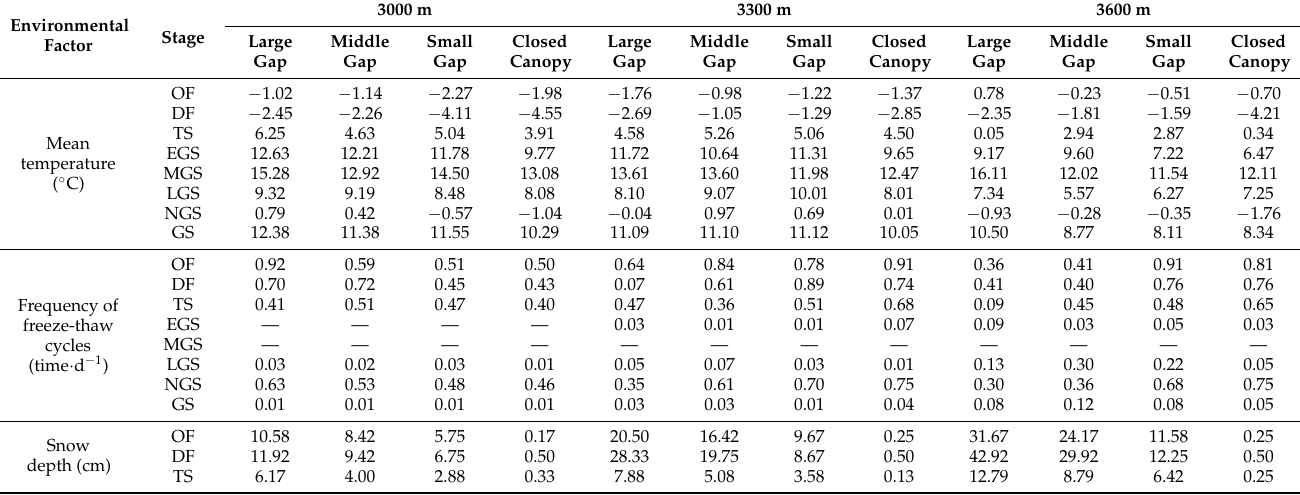
Table 1. Seasonal environmental factors of in the study sites.